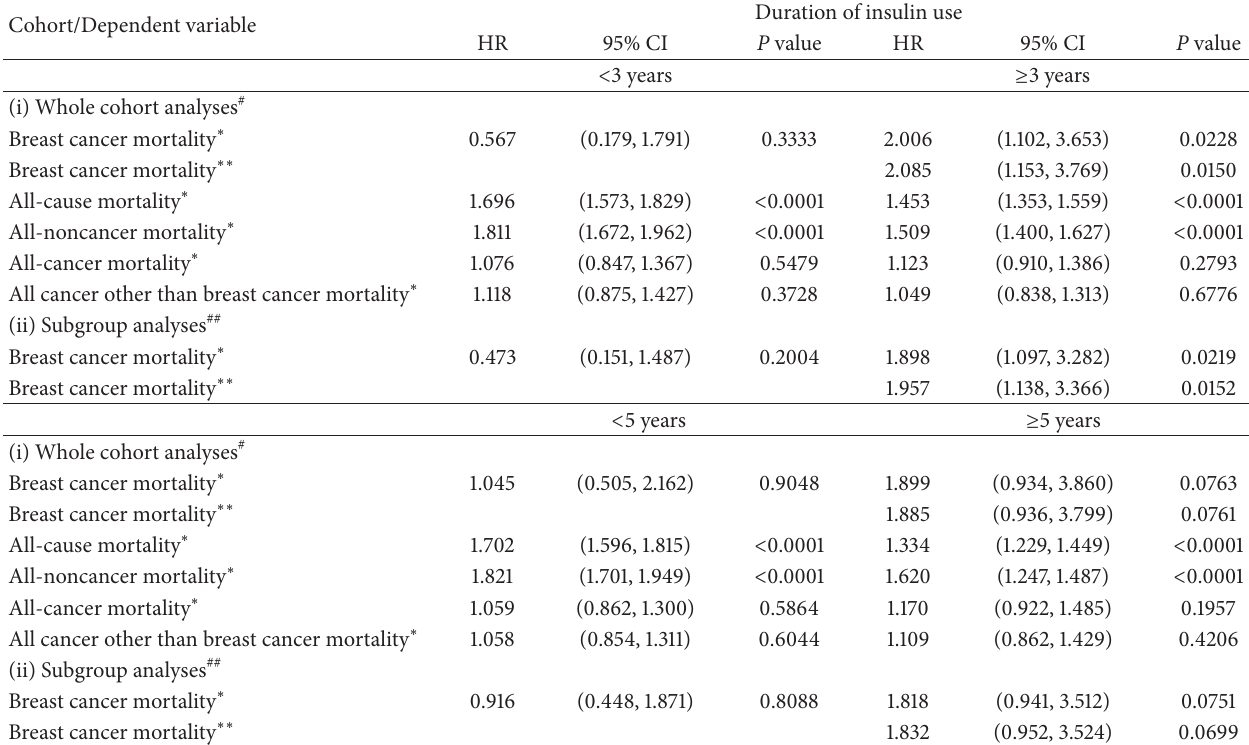
Table 3: Multivariable-adjusted hazard ratios and their 95% confidence intervals for various causes of mortality with regard to cutoffs of duration of insulin use at 3 years and 5